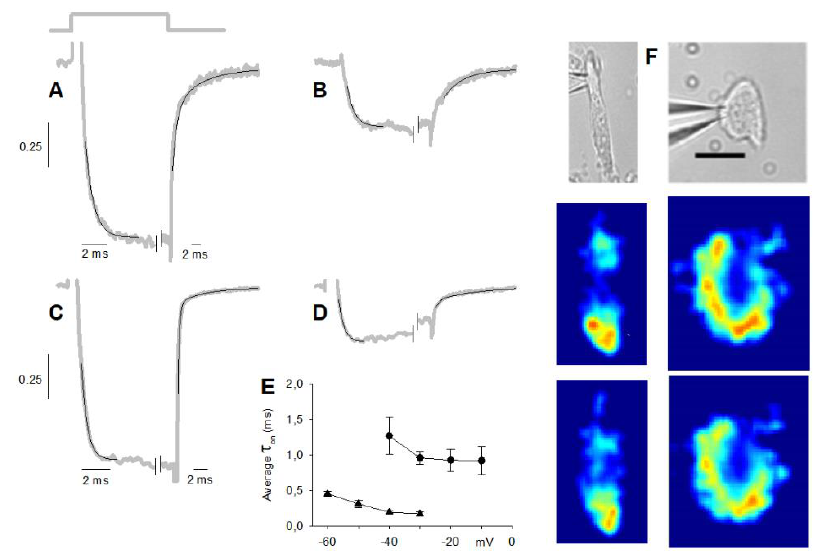
Figure 3. Exemplified exponential fittings (thin black lines) to normalised average current tracings (thick grey lines) of five cells displaying the L and R2 components. ( A ) Fittings to the activation and deactivation kinetics of the average maximal current in 4 mM Ca 2+ ; thick grey solid lines indicate the timing of the 50 ms depolarisations that applies to panel ( B – D ) as well; note the different time scale than that of panel ( C ). ( B ) Fittings to the average maximal Ca 2+ current in the presence of 10 µ M nifedipine. ( C ) Fittings to the average maximal cation current recorded in 10 nM external Ca 2+ . ( D ) Fittings to the average maximal cation current in the presence of 10 µ M nifedipine. Each one of the five cells averaged was subjected to the following fast solution exchange protocol (using the multi-barrelled pipette of Figure 2): 4 mM Ca 2+ , 4 mM Ca 2+ +nifedipine, 4 mM Ca 2+ , 10 nM Ca 2+ , 10 nM Ca 2+ + nifedipine, and finally 4 mM Ca 2+ ; the three recordings in 4 mM Ca 2+ were almost identical; depolarisation was to − 20 mV in ( A , B ) and to − 50 mV in ( C , D ); the horizontal and vertical scales of ( A ) apply to ( B ), the scales of ( C ) apply to ( D ); currents in nifedipine ( B , D ) are normalised to their own control (( A , C ), respectively), whose maximal amplitude was considered 1. ( E ) Activation kinetics ( τ on ) of the cells averaged in panel ( A ) (filled circles) and in panel ( C ) (filled triangles) at various voltages. ( F ) Top two images, bright-field video micrograph of two patched cell (scale bar, 10 µ m; upper panels); middle two images, ∆ F / F o pseudo-colour images corresponding to the two cells on top, encoded according to the colour-scale bar of Figure 1 (maximal fluorescence was 25% for the cell on the left and 20% for the cell on the right), acquired just at the offset of a 160 ms depolarisation to − 30 mV (as shown in Figure 2C) in the control; lower two images are as the middle images but during nifedipine application with the puff pipette shown in Figure 1A; all the fluorescence images are enlarged 1.5-fold compared to the bright-field video micrograph for clarity. Numbers identify the same hotpots in the pseudo-colour